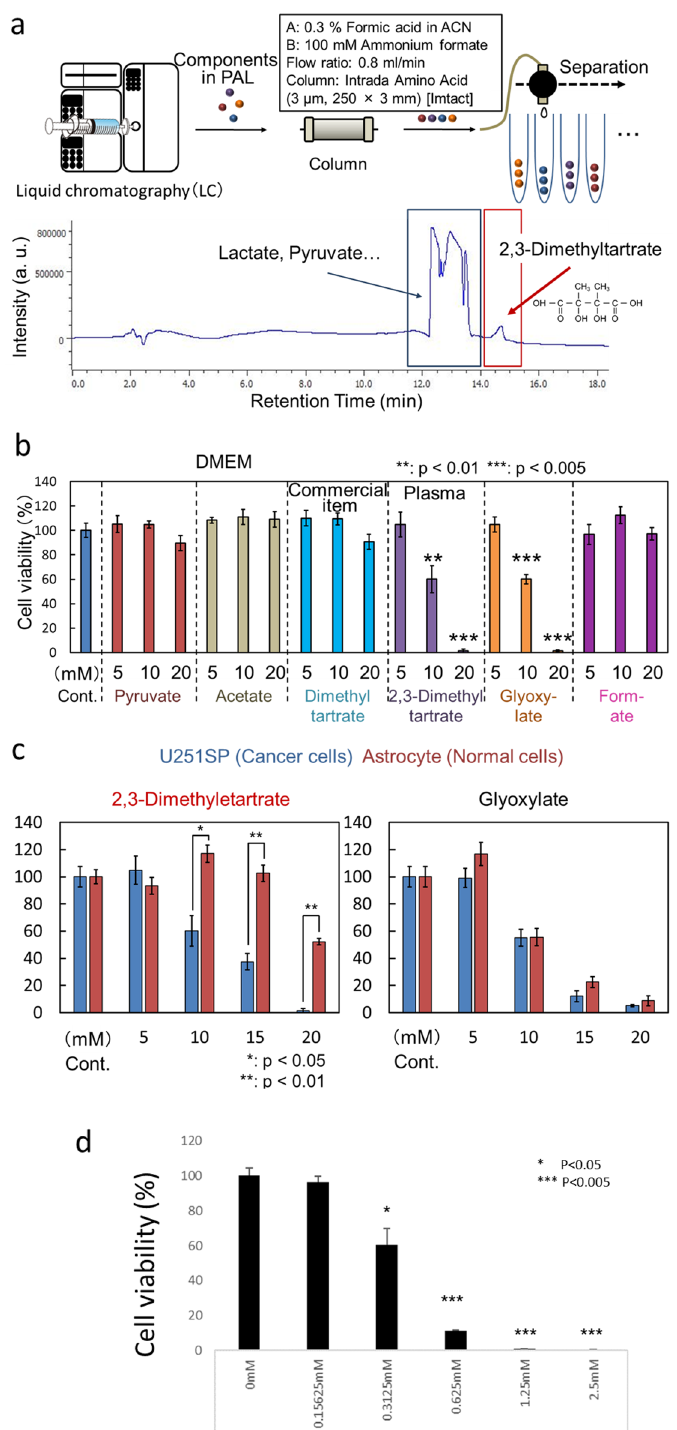
Figure 4. Anti-tumor effect of each component of PAL. ( a ) Schematic of the purification procedure for 2,3-dimetyltartrate in plasma-activated L-sodium lactate solution. ( b ) The cell viability of U251SP glioblastoma cells treated with 5, 10, or 20 mM of pyruvate, acetate, dimethyltartrate, 2,3-dimethyltartrate, glyoxylate, or formate in culture medium. ( c ) Cell viability of U251SP glioblastoma cells and normal astrocytes treated with 5, 10, 15, or 20 mM of 2,3-dimethyltartrate or glyoxylate in culture medium. ( d ) The cell viability of U251SP glioblastoma cells treated with 0.15625, 0.3125, 0.625, 1.25, or 2.5 mM of synthesized 2,3-dimethyltartrate in